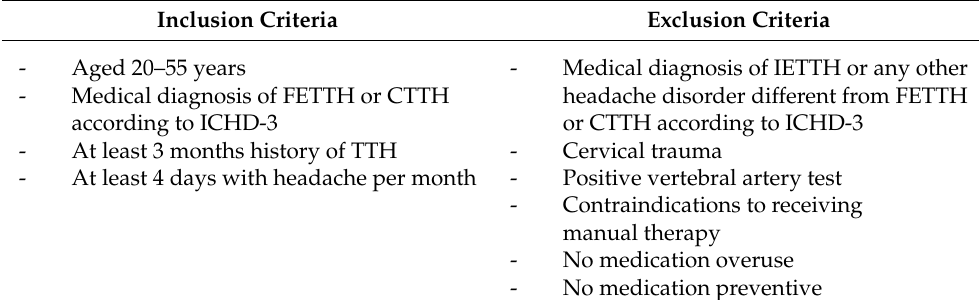
Table 1. Inclusion and exclusion criteria. Inclusion Criteria Exclusion